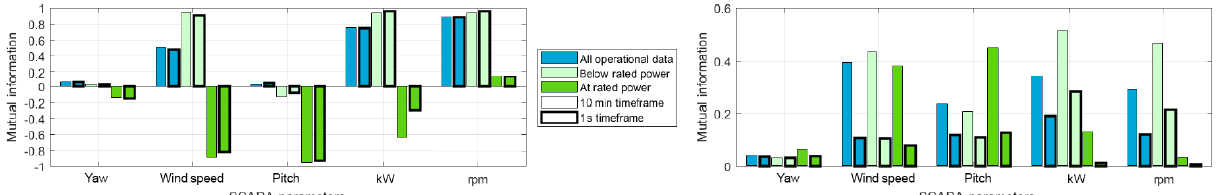
Figure 3. The Pearson correlation is calculated between thrust load averages and five standard SCADA parameters for operational data only. Both 10min and 1s averages are considered. The total dataset is divided based on the operational state of the turbine (operating below rated power and operating at rated power). Table 1. The selected output variables for FAST simulations. Parameter Category Description Unit Wind1VelX InflowWind Nominally downwind component of the hub-height wind ms − 1 velocity BldPitch1 ElastoDyn – blade pitch motions Blade pitch angle (position) ◦ LSSGagVxa ElastoDyn – shaft motions Low-speed shaft strain gage angular speed (on the gearbox rpm side of the low-speed shaft YawPzn ElastoDyn – nacelle yaw motions Nacelle yaw angle (position) ◦ TwrBsMyt ElastoDyn – tower base loads Tower base pitching (or fore-aft) moment (i.e., the moment kNm caused by fore-aft forces) GenPwr ServoDyn – generator and torque control Electrical generator power